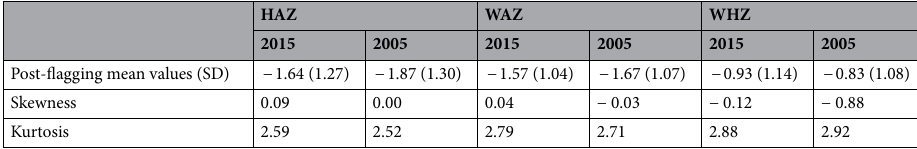
Table 3. Z-score normality assessment of the unflagged data.